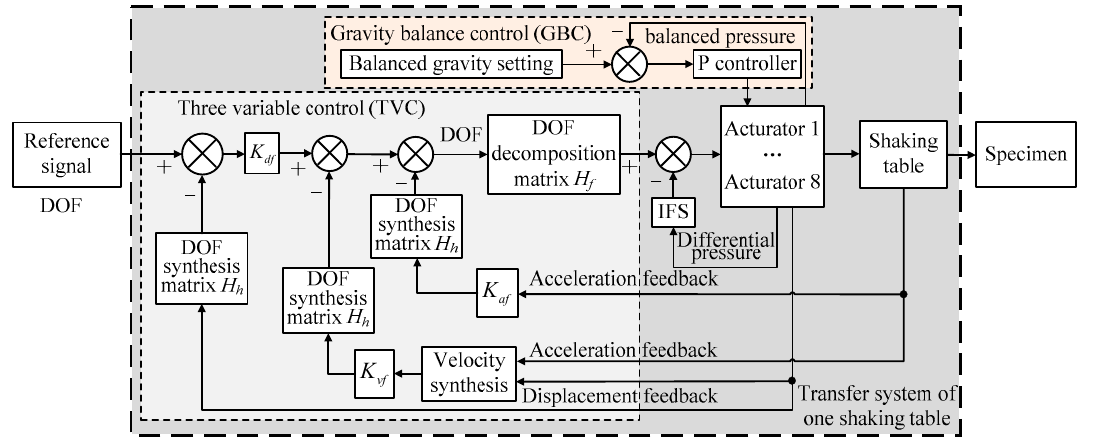
Figure 8. The fundamental control scheme of one shaking table system.